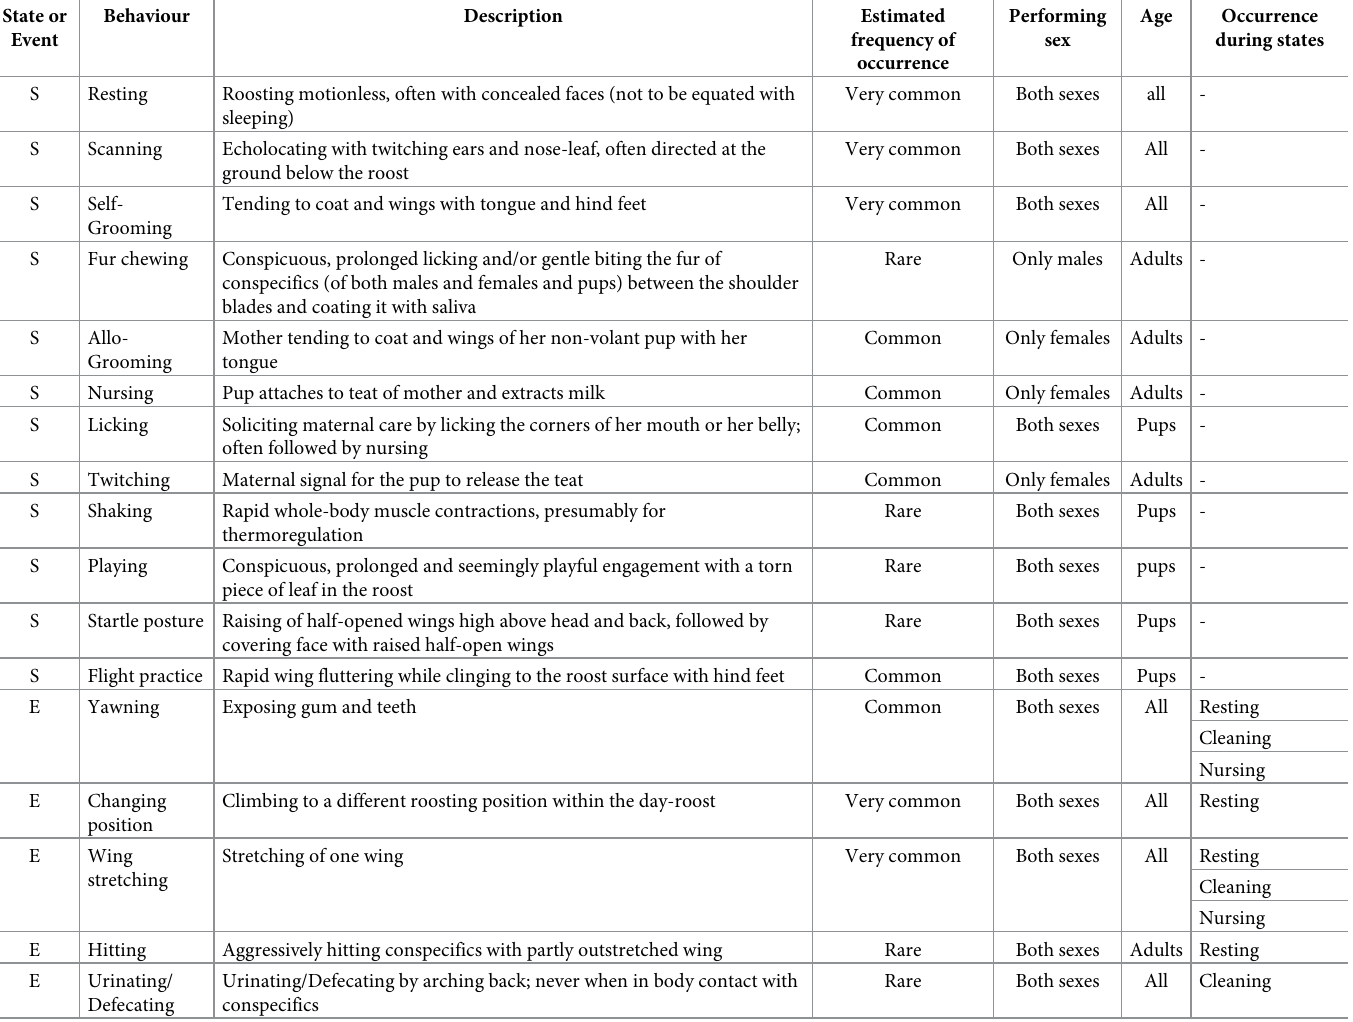
Table 1. Ethogram describing behaviours of E . alba observed in the